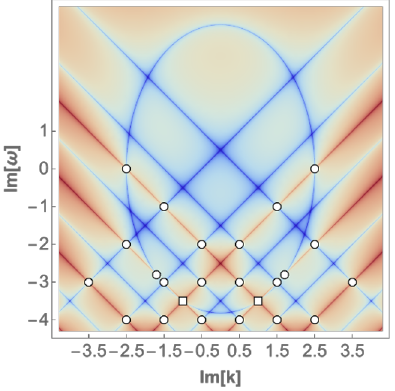
(Im[ ω ] , Im[ k ]) | at d = 4 , ∆ = 4 . 5 ( δ = 2 . 5) . The blue lines and red lines represent Figure 9 . log |G ∆ V zeros and poles of the Green’s function, respectively. The white circles and squares are type I and type II pole-skipping points respectively. Compared to the massless (∆ = d − 1) vector’s Green’s function, massive (∆ 6 = d − 1) vector’s one have elliptic blue line instead of the vertical blue lines in figure 4. In general, such zero line’s shape is conical section. Thus, its shape can also be circle, parabola and hyperbola depending on the value of ∆ , d . Note that there exist the